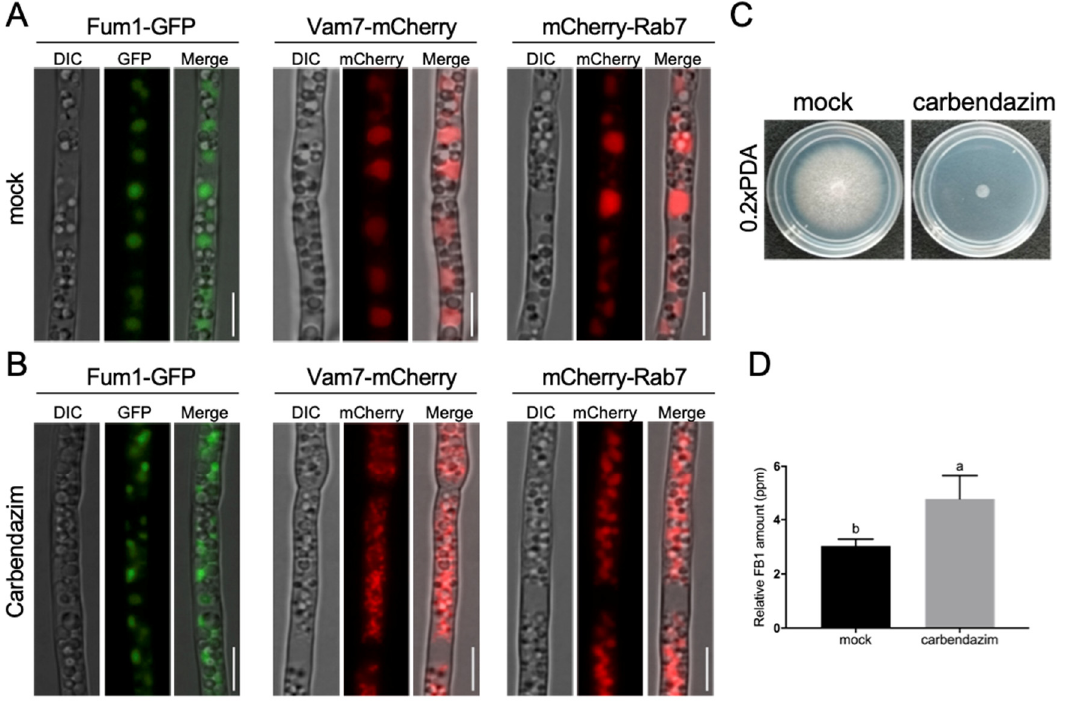
Figure 5. Carbendazim impacts on FB 1 biosynthesis. Fum1-GFP, Vam7-mCherry, and Rab7-mCherry strains were inoculated in myro liquid medium without ( A ) and with ( B ) 1 µ g/mL carbendazim treatment. Scale bar = 5 µ m. ( C ) Sensitivity to carbendazim was shown by culturing WT on 0.2 × PDA or 0.2 × PDA + carbendazim (1 µ g/mL) for 7 plates at 28 ◦ C. ( D ) FB 1 production in WT were tested after being cultured in myro broth with and without 1 µ g/mL carbendazim for 8 days of shaking at room temperature. Different letters on the bars indicated significance according to prism unpaired t -test at p < 0.05.